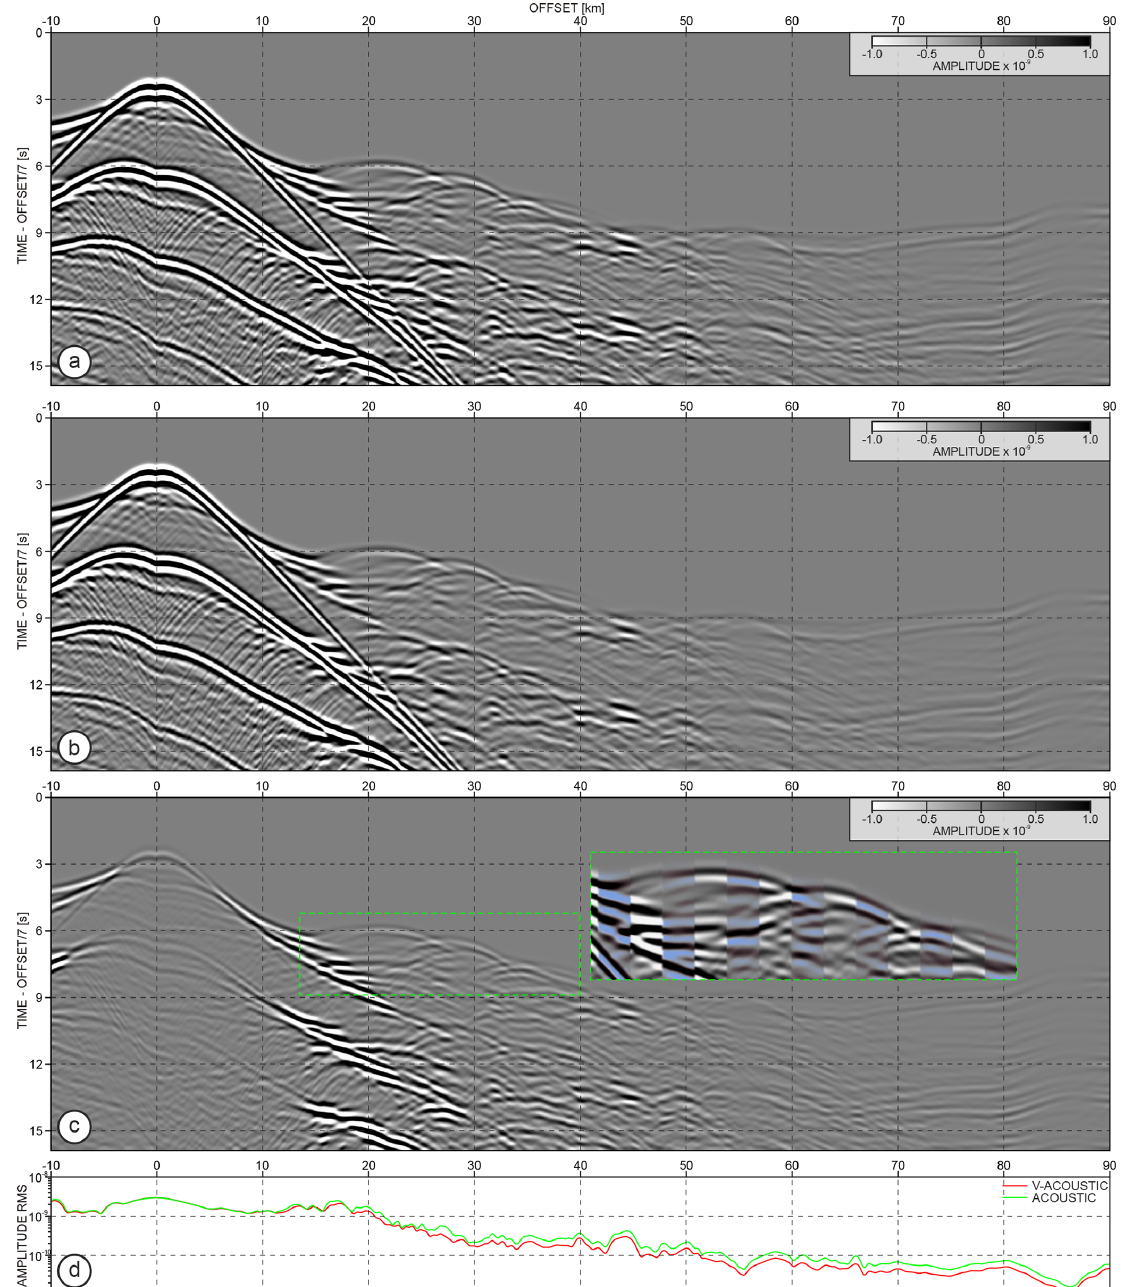
Figure 10. OBS gathers generated using 2D finite-difference (a) acoustic and (b) visco-acoustic waveform modelling. (c) Difference between (a) and (b) . The inset shows time shifts between the groups of 20 interleaved traces from (a) (blue shading) and (b) extracted within green dashed rectangles. (d) Rms amplitude curves of the gathers from (a, b)